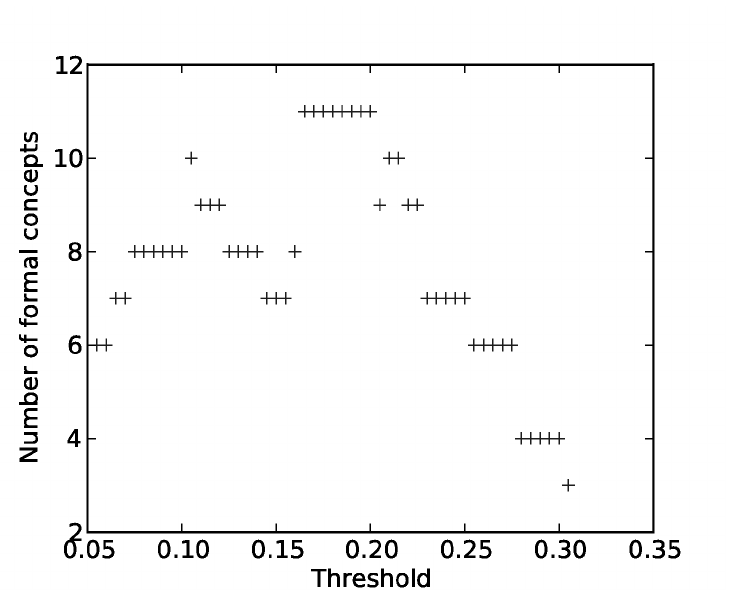
Figure 4: Number of formal concepts (including the bottom and top trivial ones) in function of the threshold applied to the weighted relation W of the formal context in Figure